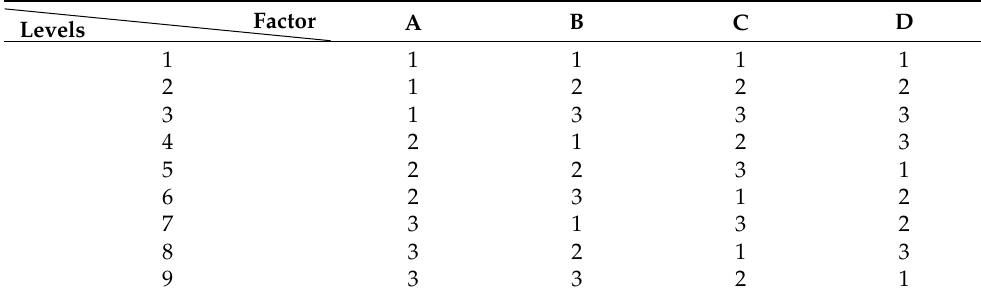
Table 3. Orthogonal experimental design